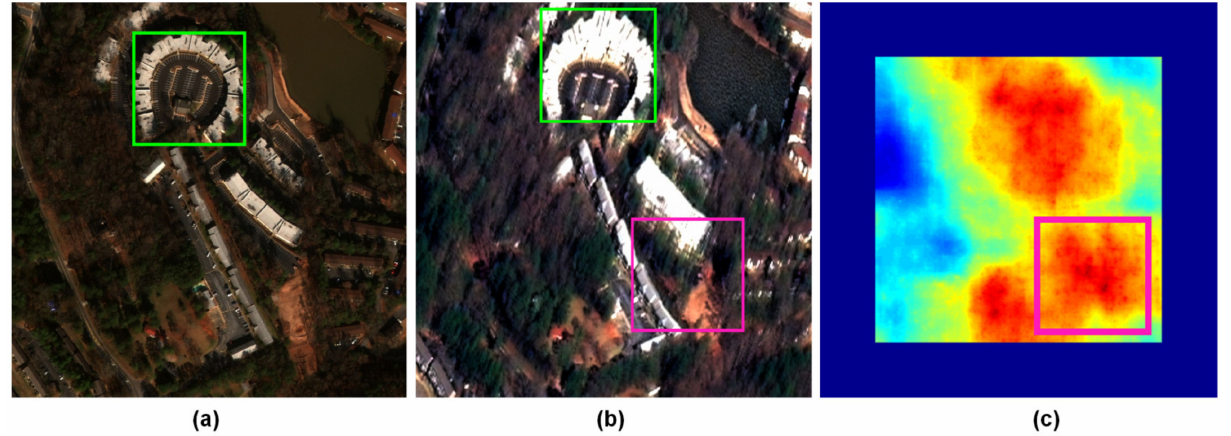
Figure 9. The result of the DDIS matching method. ( a ) The template marked in green. ( b ) The detected target on 52 ◦ off-nadir image. ( c ) The corresponding matching likelihood map.